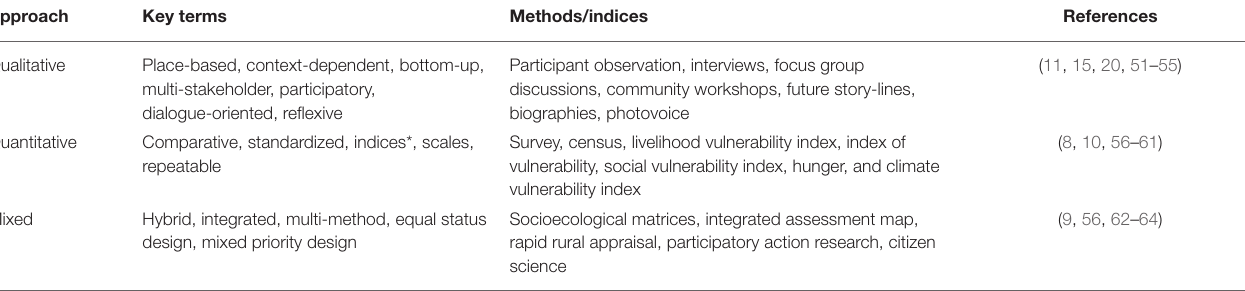
TABLE 2 | “Cooking tools” for consideration: qualitative, quantitative, and mixed methods.